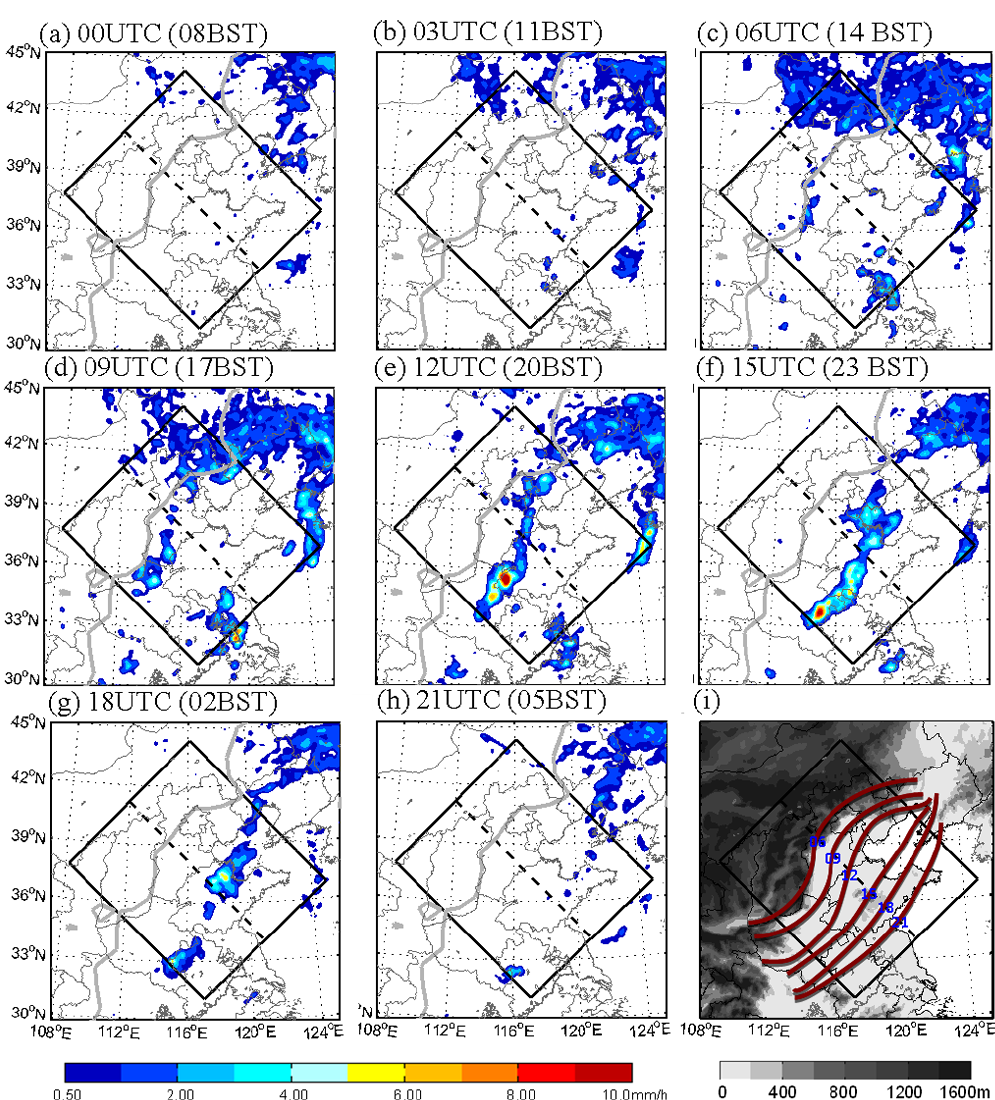
Fig. 5. Spatial distribution of diurnal hourly precipitation rate for final 10 days of CNTL at (a) 00:00UT; (b) 03:00UT; (c) 06:00UT; (d) 09:00UT; (e) 12:00UT; (f) 15:00UT; (g) 18:00UT; and (h) 21:00UT. (i) Isochrones (phase fronts) of the local diurnal precipitation peaks at different times with terrain elevations shaded every 200m. The isochrones are labeled in